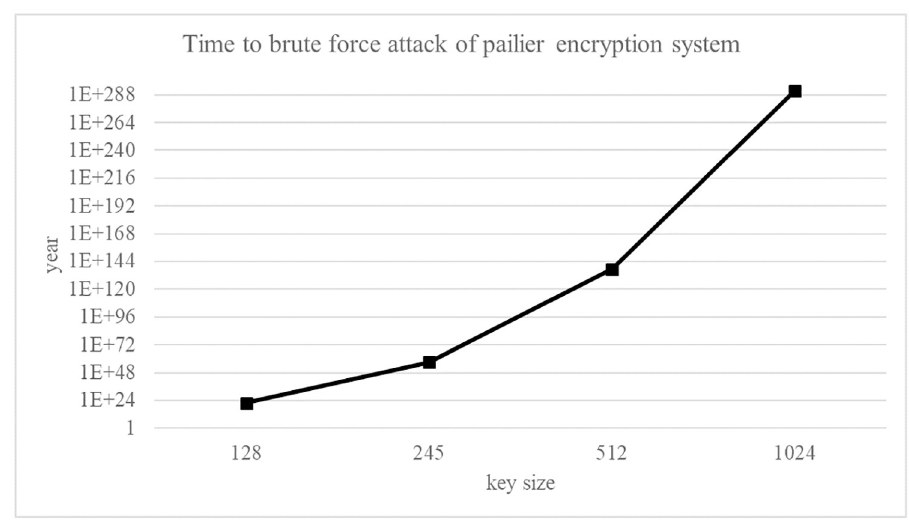
Fig 16. Brute force attack time with varying the key